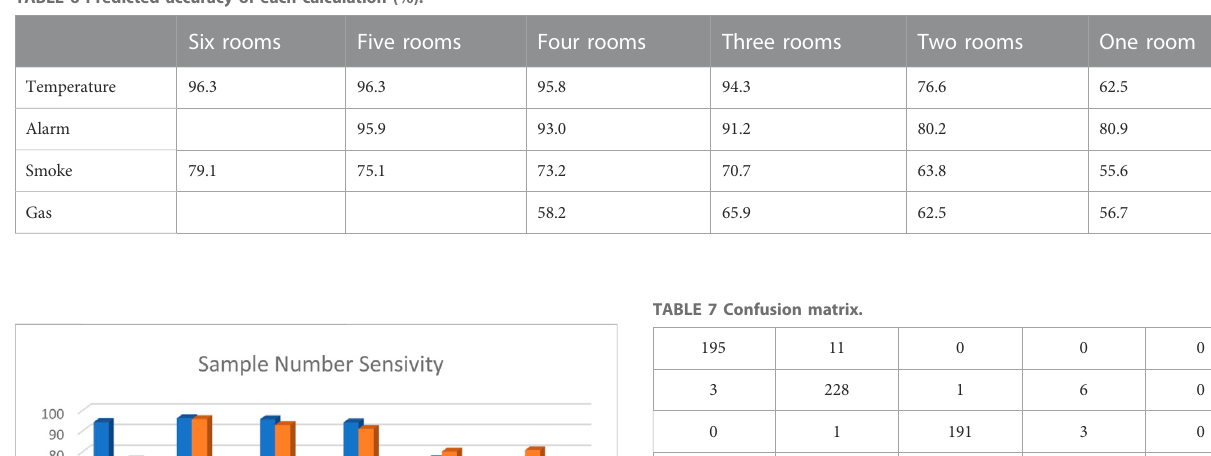
TABLE 6 Predicted accuracy of each calculation (%).